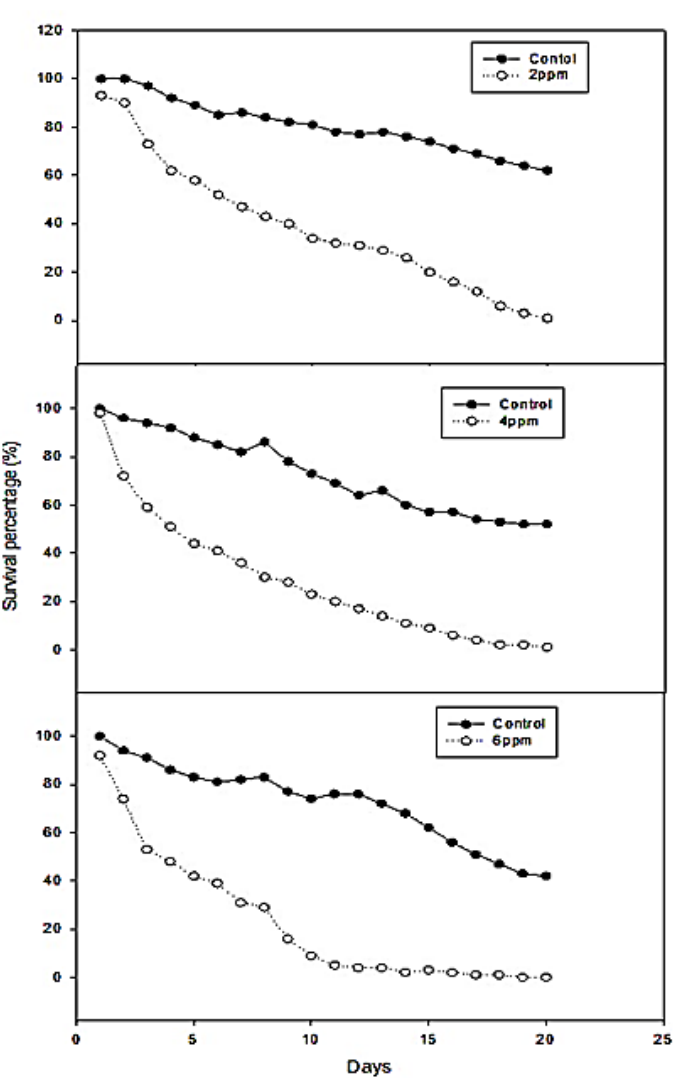
Figure 2. Mean percentage larvae mortality at 20 days after treatment. S. litura fed on leaves with 2, 4 and 6 ppm of Db-Precocene I.